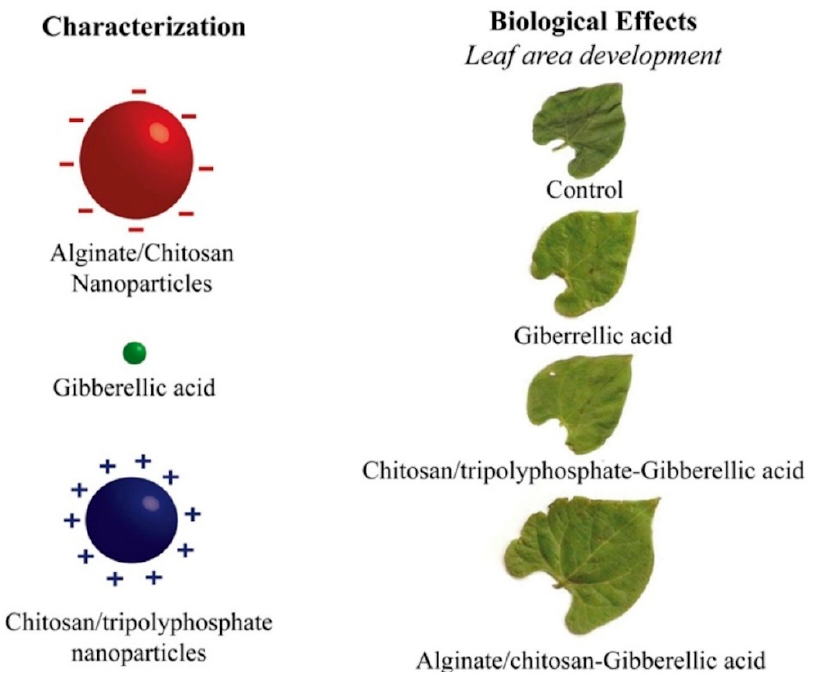
Figure 10. ALG/CS and CS/TPP nanoparticles, gibberellic acid, and the effects of treatment with GA, ALG/CS–GA, and CS/TPP–GA nanoparticles on the leaves’ area. Reproduced with permission from [140], 2017, Elsevier .